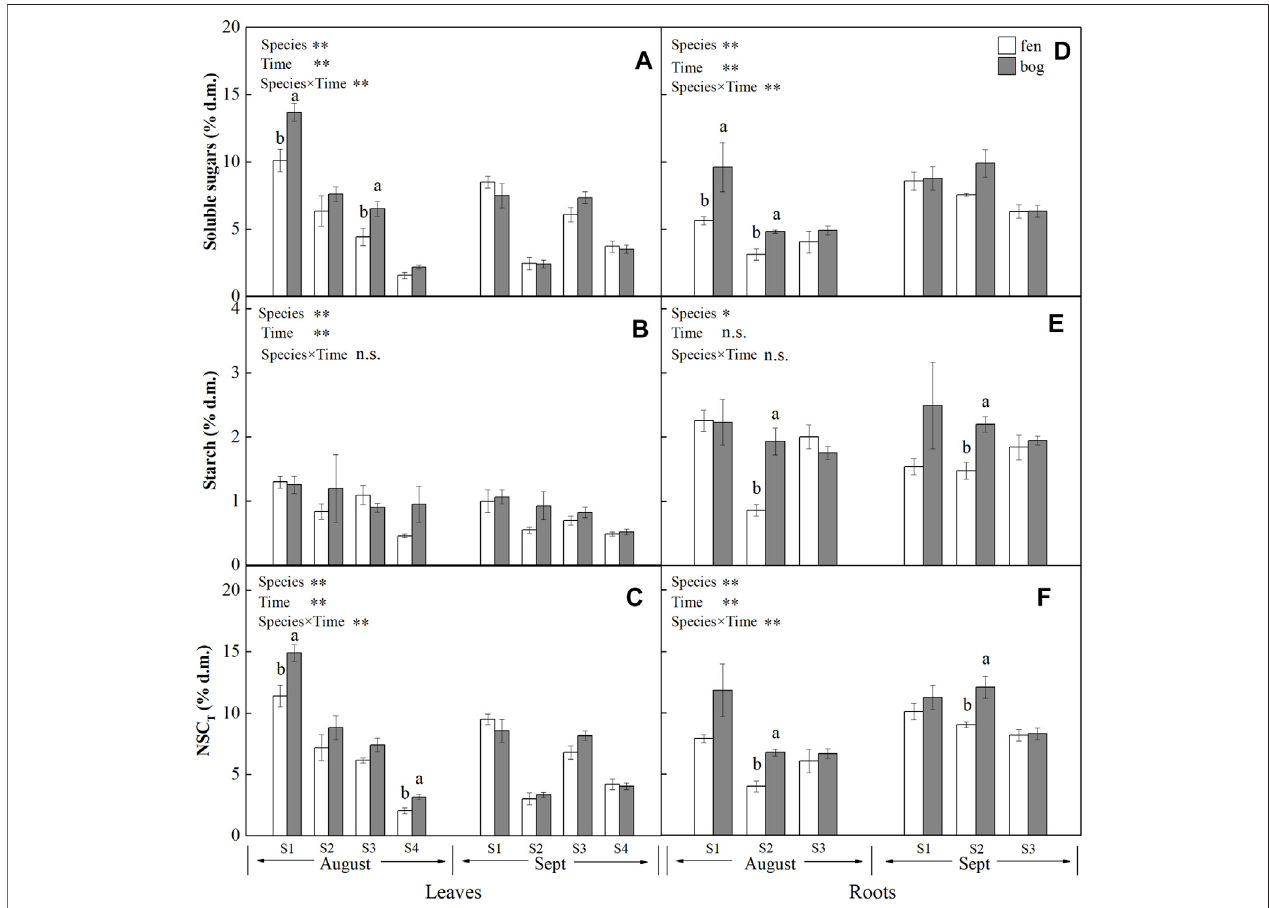
FIGURE1 | Concentrations (mean ± SE; % ofdry matter) ofsoluble sugars, starch, and NSC T in leaves and roots ofplants grown in fens ( n =5) and bogs ( n = 4) in the mid-season and end-season. Different lowercase letters display signi fi cant differences between fens and bogs for each species within each time, tested with t -test ( p < 0.05). S1 – S4 represent Betula fruticosa Pall., Phragmites australis (Clav.), Carex lasiocarpa Ehrh. , and Sphagnum magellanicum ,